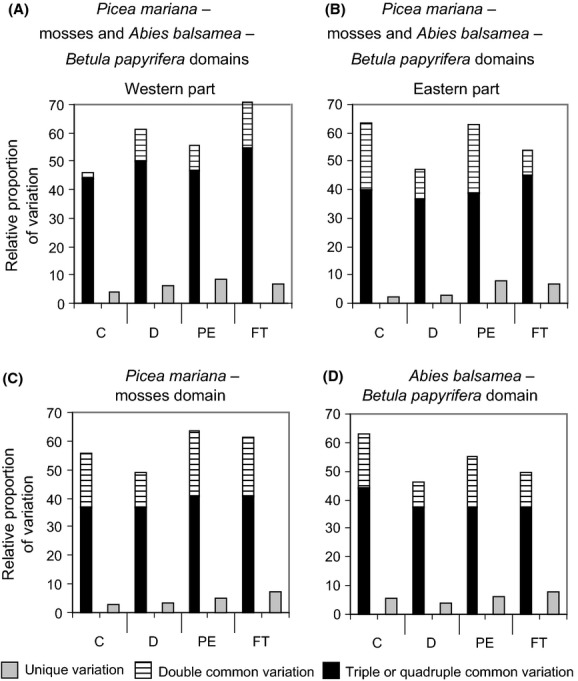
Synthetic view of the relative proportion of variation (%) in the abundance of the ericaceous species (combined) explained by four sets of explanatory variables (climate [C], disturbances (natural and human) [D], physical environment [PE], and forest types [FT]), separately considering the (A) western part of the study region, which includes the western parts of the Picea mariana–mosses and Abies balsamea–Betula papyrifera bioclimatic domains, (B) eastern part of the study region, which includes the eastern parts of the Picea mariana–mosses and Abies balsamea–Betula papyrifera bioclimatic domains, (C) northern part of the study region, corresponding to the entire Picea mariana–mosses bioclimatic domain, and (D) southern parts of the study region, corresponding to the entire Abies balsamea–Betula papyrifera bioclimatic domain (refer to Fig.2 for bioclimatic domain localization). The variation is defined by the common and unique fractions as illustrated in Figure3C.